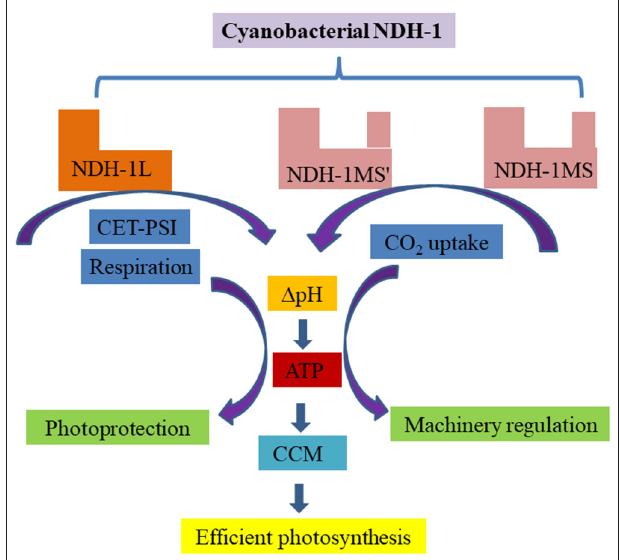
FIGURE 1 | A schematic representation of the possible mechanism of cyanobacterial NDH-1 in photosynthesis. As NDH-1L is involved in CET-PSI and respiratory pathways, NDH-1MS’ and NDH-MS participate in CO 2 uptake. These pathways couple the generation of trans-thylakoid membrane proton gradient to synthesize ATP for photoprotection, photosynthetic machinery regulation, and energy supply for carbon assimilation, especially under changing